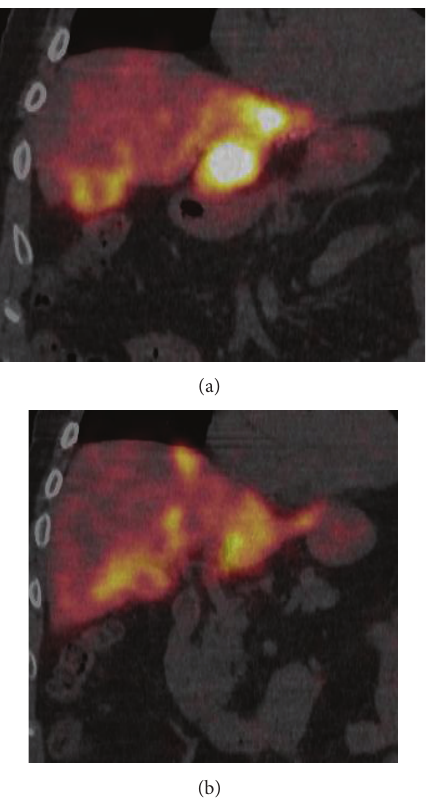
Figure 2: (a) and (b) Coronal fused SPECT/CT MAA study demon- strates multifocal hepatic uptake without gastrointestinal